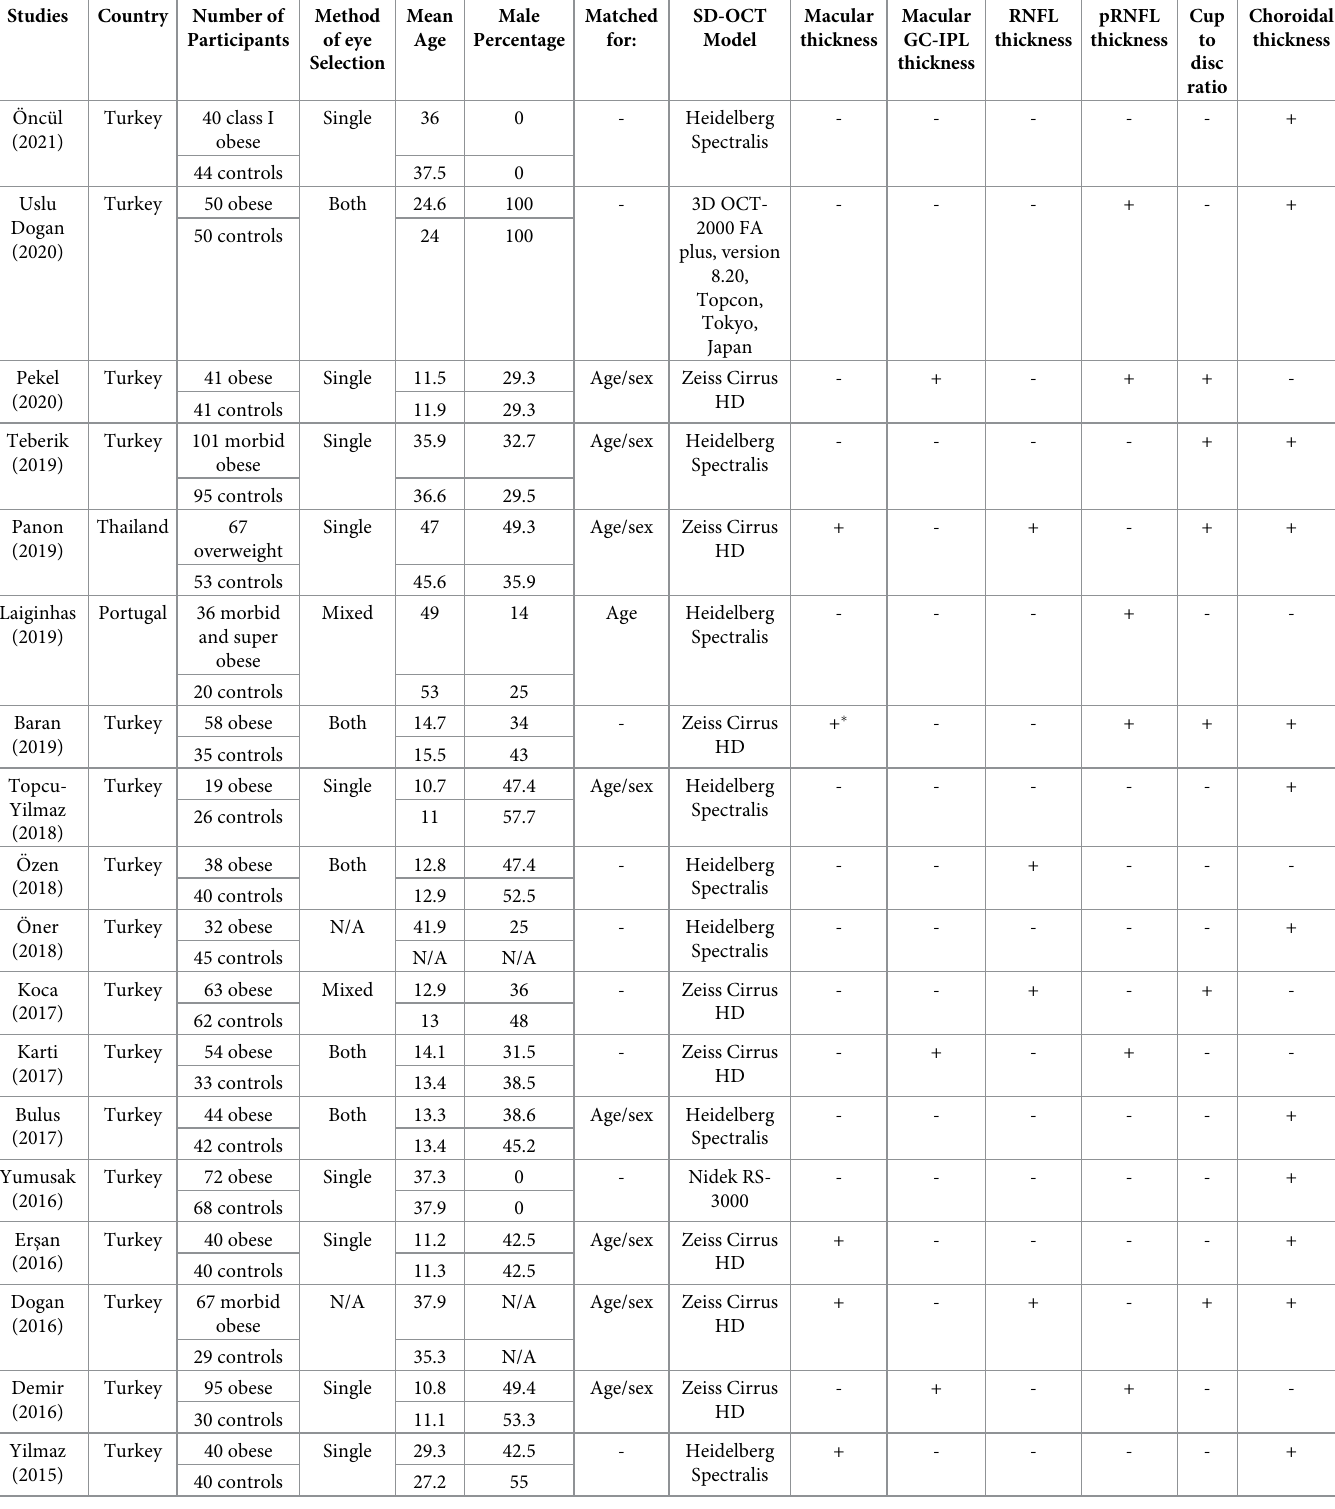
Table 1. Characteristics, population, and discussed variable of the included